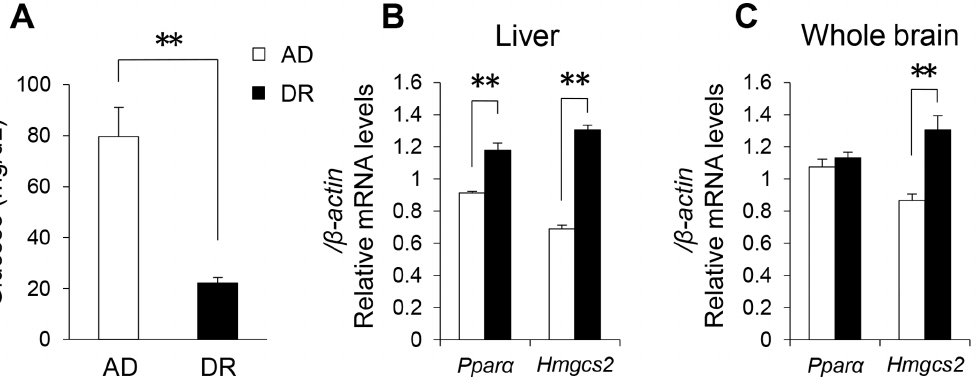
Figure 5. Metabolic state in fetal stage (gestation day 17). Blood glucose (A) and gene expression related to the regulation of lipid metabolism in liver (B) and whole brain (C). Open bars indicate AD mice. Closed bars indicate DR mice. Data represent means 6 SEM (A–C; n=6). **p , 0.01 indicates a significant difference.